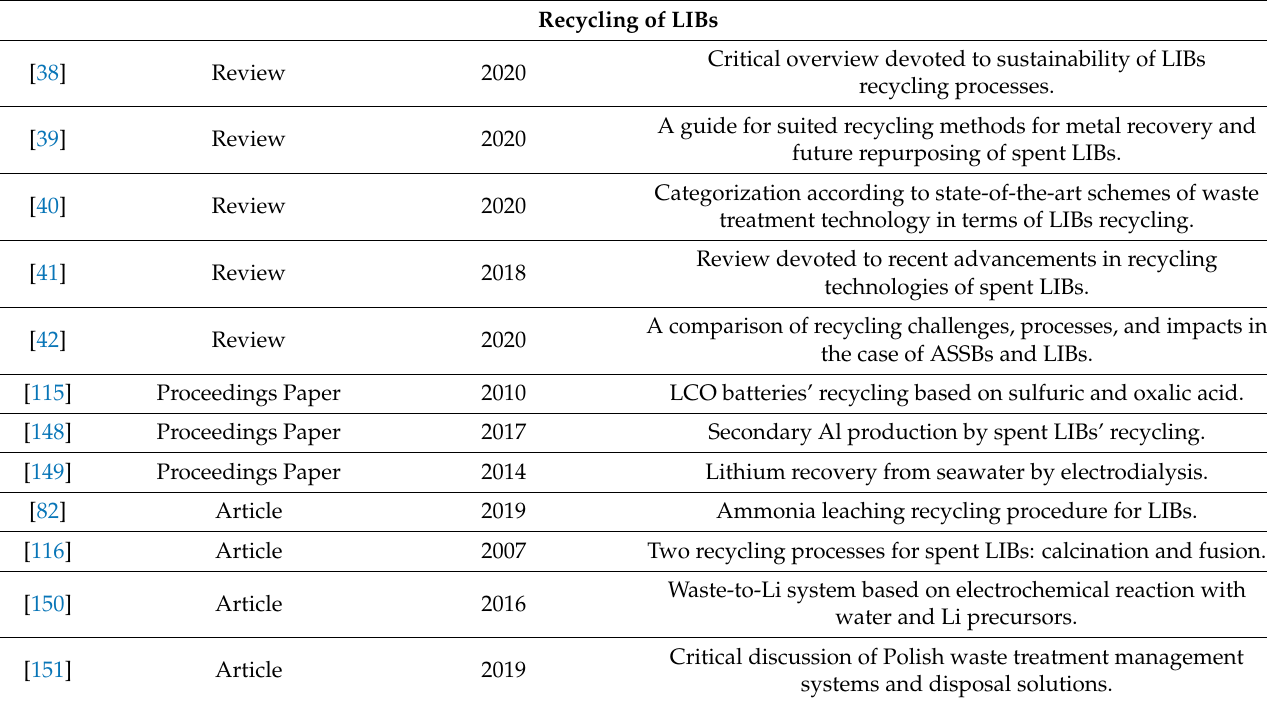
Table A8. Assessed literature in review for “Recycling of LIBs”